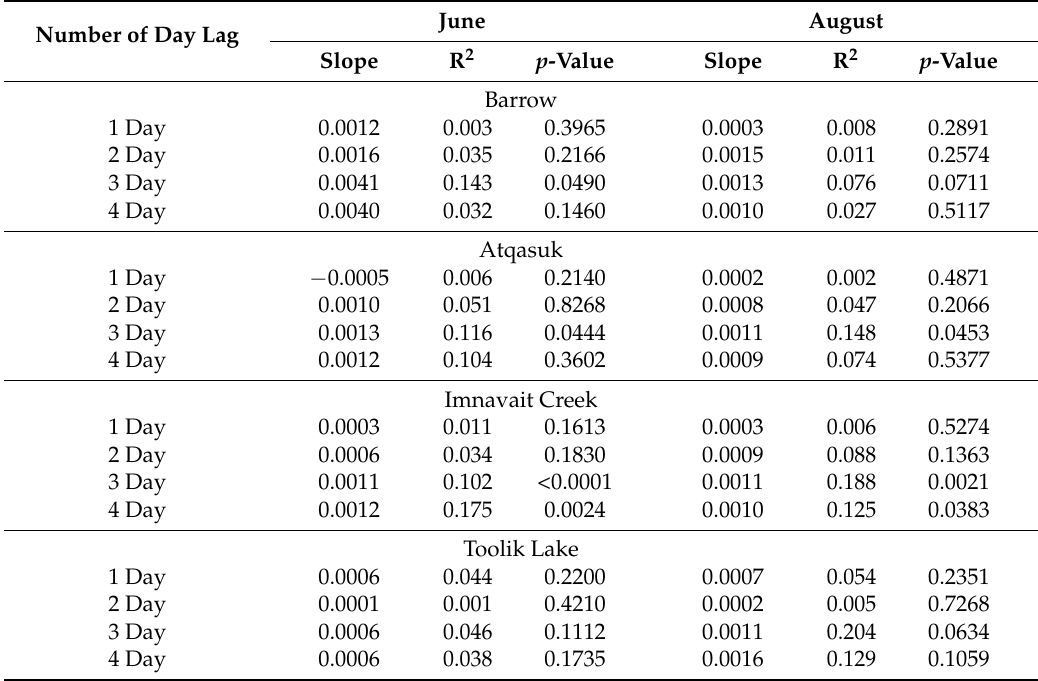
Table A1. Results of linear regression analysis of NDVI changes in 1-, 2-, 3-, and 4-day time periods for the four full MISP transects in the months of June and